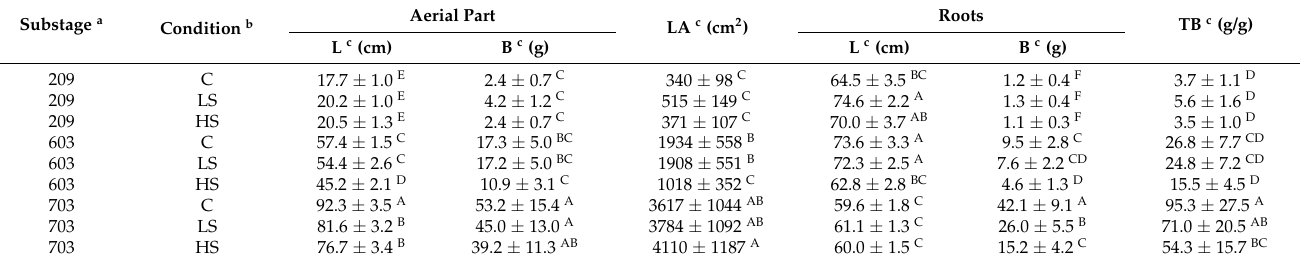
Table 1. Growth parameters of P. peruviana plants along three growth substages under salinized conditions. Substage